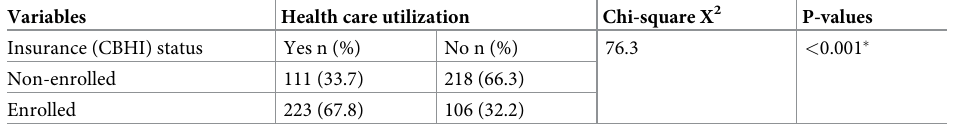
Table 4. Healthcare utilization and community health insurance enrolment in South Gondar Zone, Northwest Ethiopia, 2021 (n =